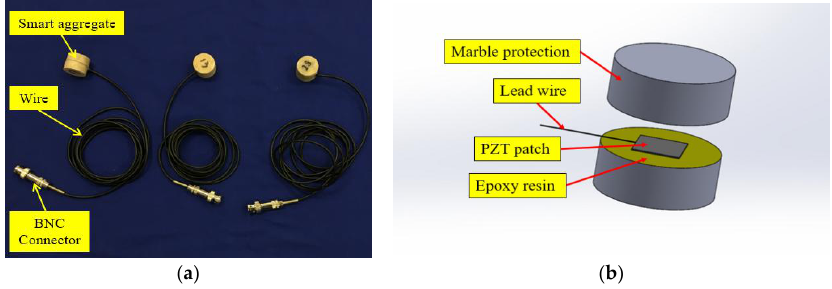
Figure 2 . Smart aggregate ( a ) photo and ( b ) internal structure. Figure 2. Smart aggregate ( a ) photo and ( b ) internal